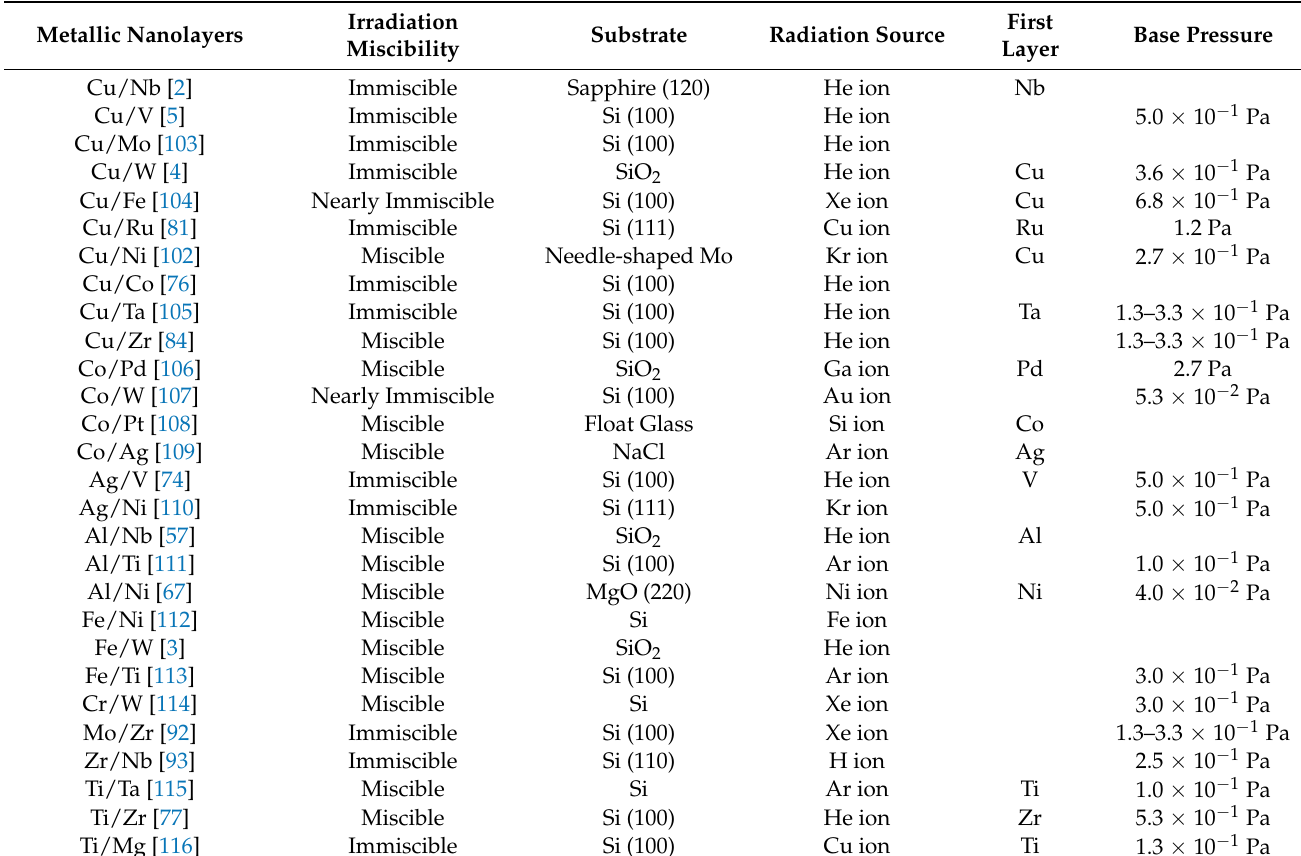
Table 5. A summary of previous studies on various metallic multilayer films irradiated by different sources. Metallic